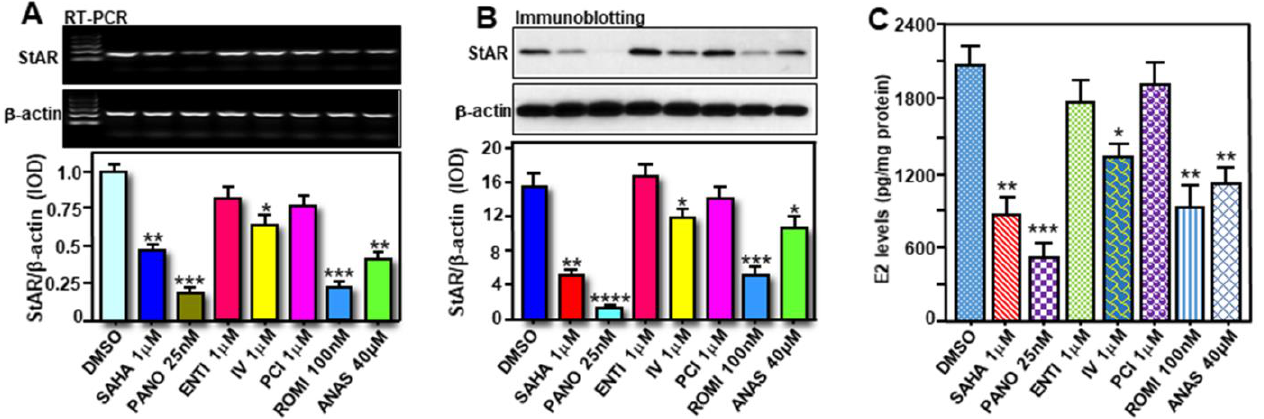
Figure 7. Effects of a variety of HDACIs on StAR expression and E2 synthesis in MCF7 cells. These cells were treated without (DMSO) or with SAHA (1 µ M), PANO (25 nM), Entinostat (ENTI, 1 µ M), IV (1 µ M), PCI-34051 (PCI, 1 µ M), ROMI (100 nM), and ANAS (40 µ M), for 24 h. After treatments, cells were processed for total RNA extraction with PureLink RNA mini kit, and StAR mRNA expression was determined by a semi-quantitative RT-PCR ( A ). Representative gel images illustrate expression of StAR and β -actin mRNA levels in different treatment groups. Cells were also homogenized in RIPA lysis buffer and subjected to whole cell extract preparation, and representative immunoblots illustrate StAR protein expression using 50 μ g of total protein ( B ). β -actin expression was assessed as a loading control. IOD values for StAR mRNA and StAR protein, in each band, were quantified and normalized with the corresponding β -actin bands, and presented ( A,B ; bottom panels). E2 levels in media were determined by ELISA and presented as pg/mg protein ( C ). Data represent the mean ± SE of three to four independent experiments. *, p < 0.05; **, p < 0.01; ***, p < 0.001; ****, p < 0.0001 vs. DMSO.